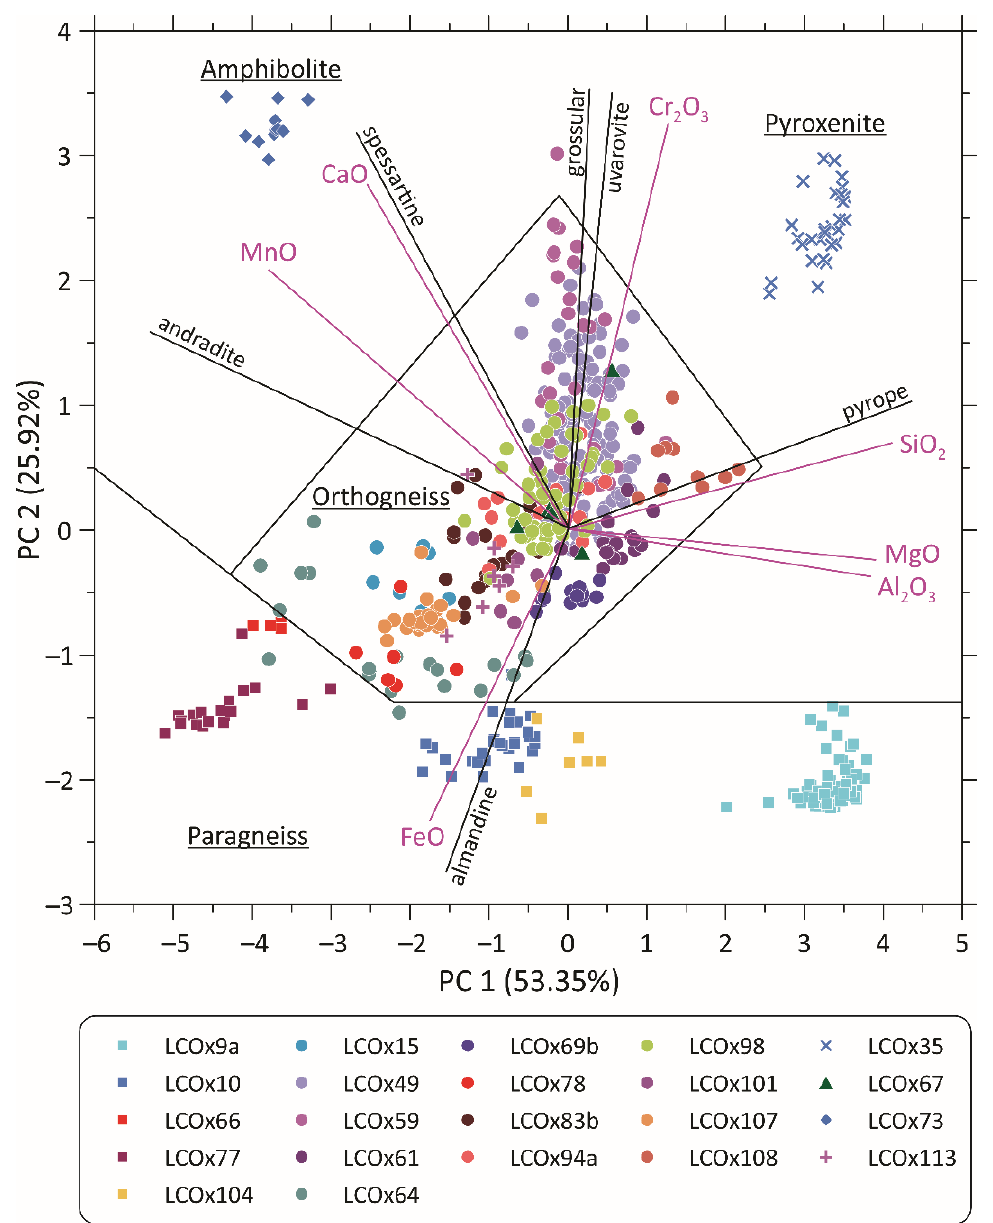
Figure 6. Principal Component Analysis (PCA) of Grt major oxides. Principal Components 1 and 2 are shown with their explained percentage of